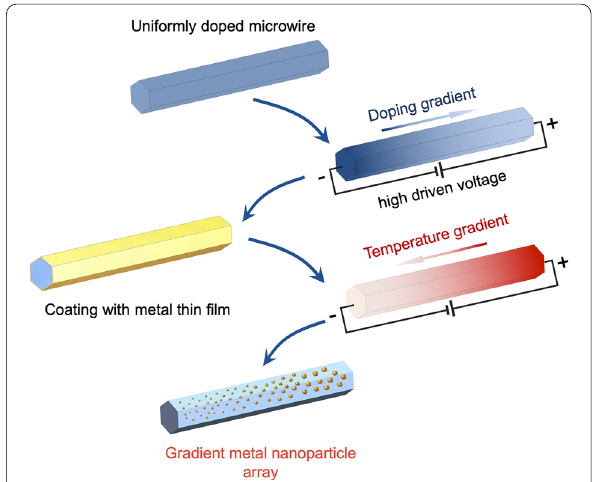
Fig. 1 Fabrication scheme of metal